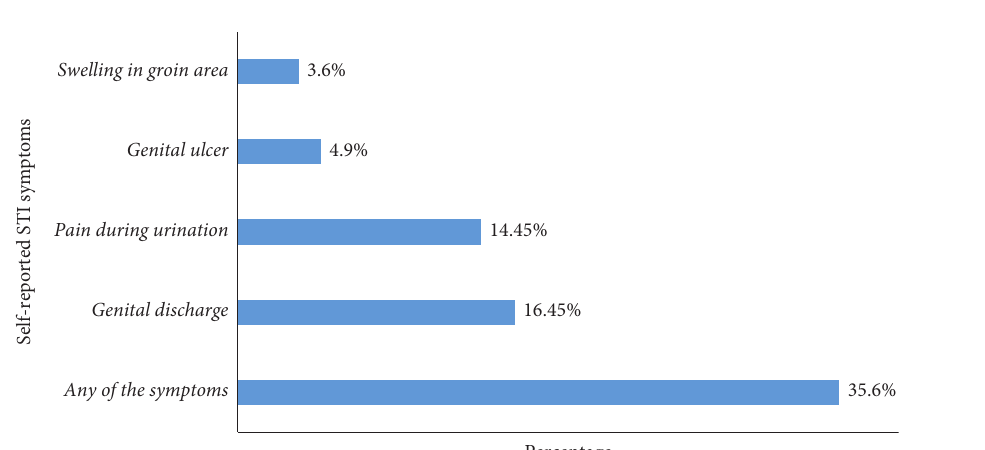
Figure 1: Prevalence of self-reported STI symptoms among FSWs working in licensed drinking establishments of Adama Town, Oromia regional state, Ethiopia, March 2017 ( N �